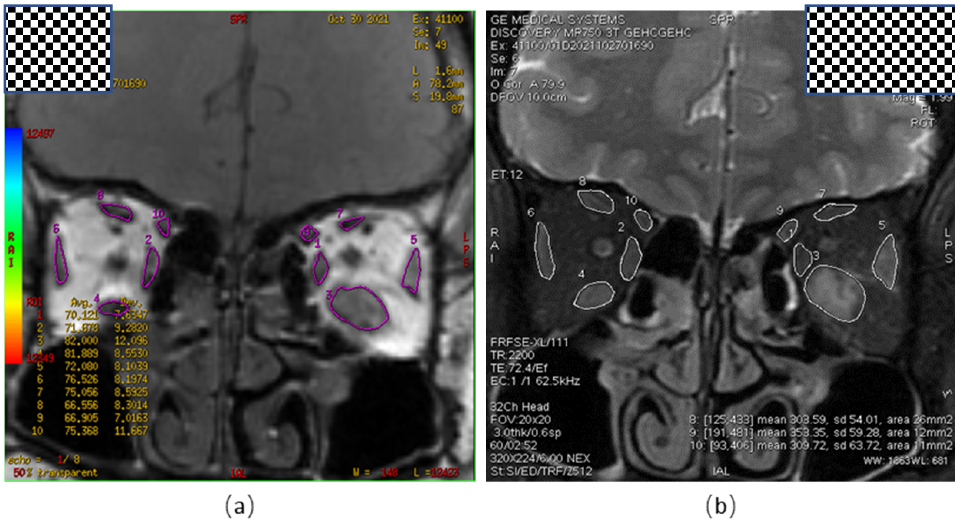
Figure 1. Measurement of Orbital MRI-T2 Mapping Parameters. ( a ) Orbital coronal pseudo-color map, representing the T2RT value of the ROI in each EOM; ( b ) orbital coronal view, indicating the largest cross-sectional area of the EOM. T2RT, T2 relaxation time; ROI, region of interest; EOM, extraocular muscles.